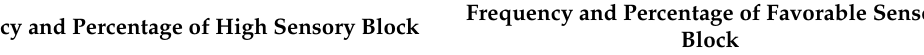
Table 4. Apparent validation of the suggested effective dose range in achieving favorable and high sensory